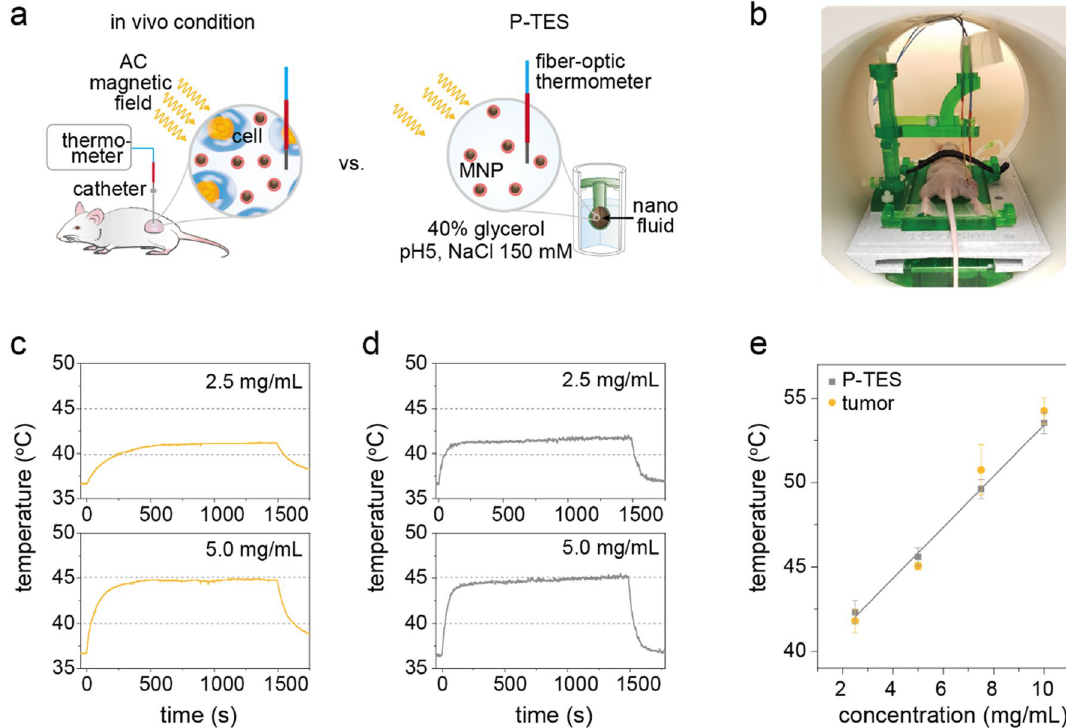
Figure 5. Verification of P-TES for MNFH application. ( a ) Schematic illustrations showing the comparison between the in vivo environment and the P-TES during MNFH. ( b ) A picture of experimental setup of in vivo real-time monitoring system for MNFH. ( c , d ) AC temperature rising curve measured at a tumor xenograft mouse model ( c ) and P-TES ( d ). ( e ) The comparison of maximum temperature during MNFH. In vivo animal model, orange; P-TES,